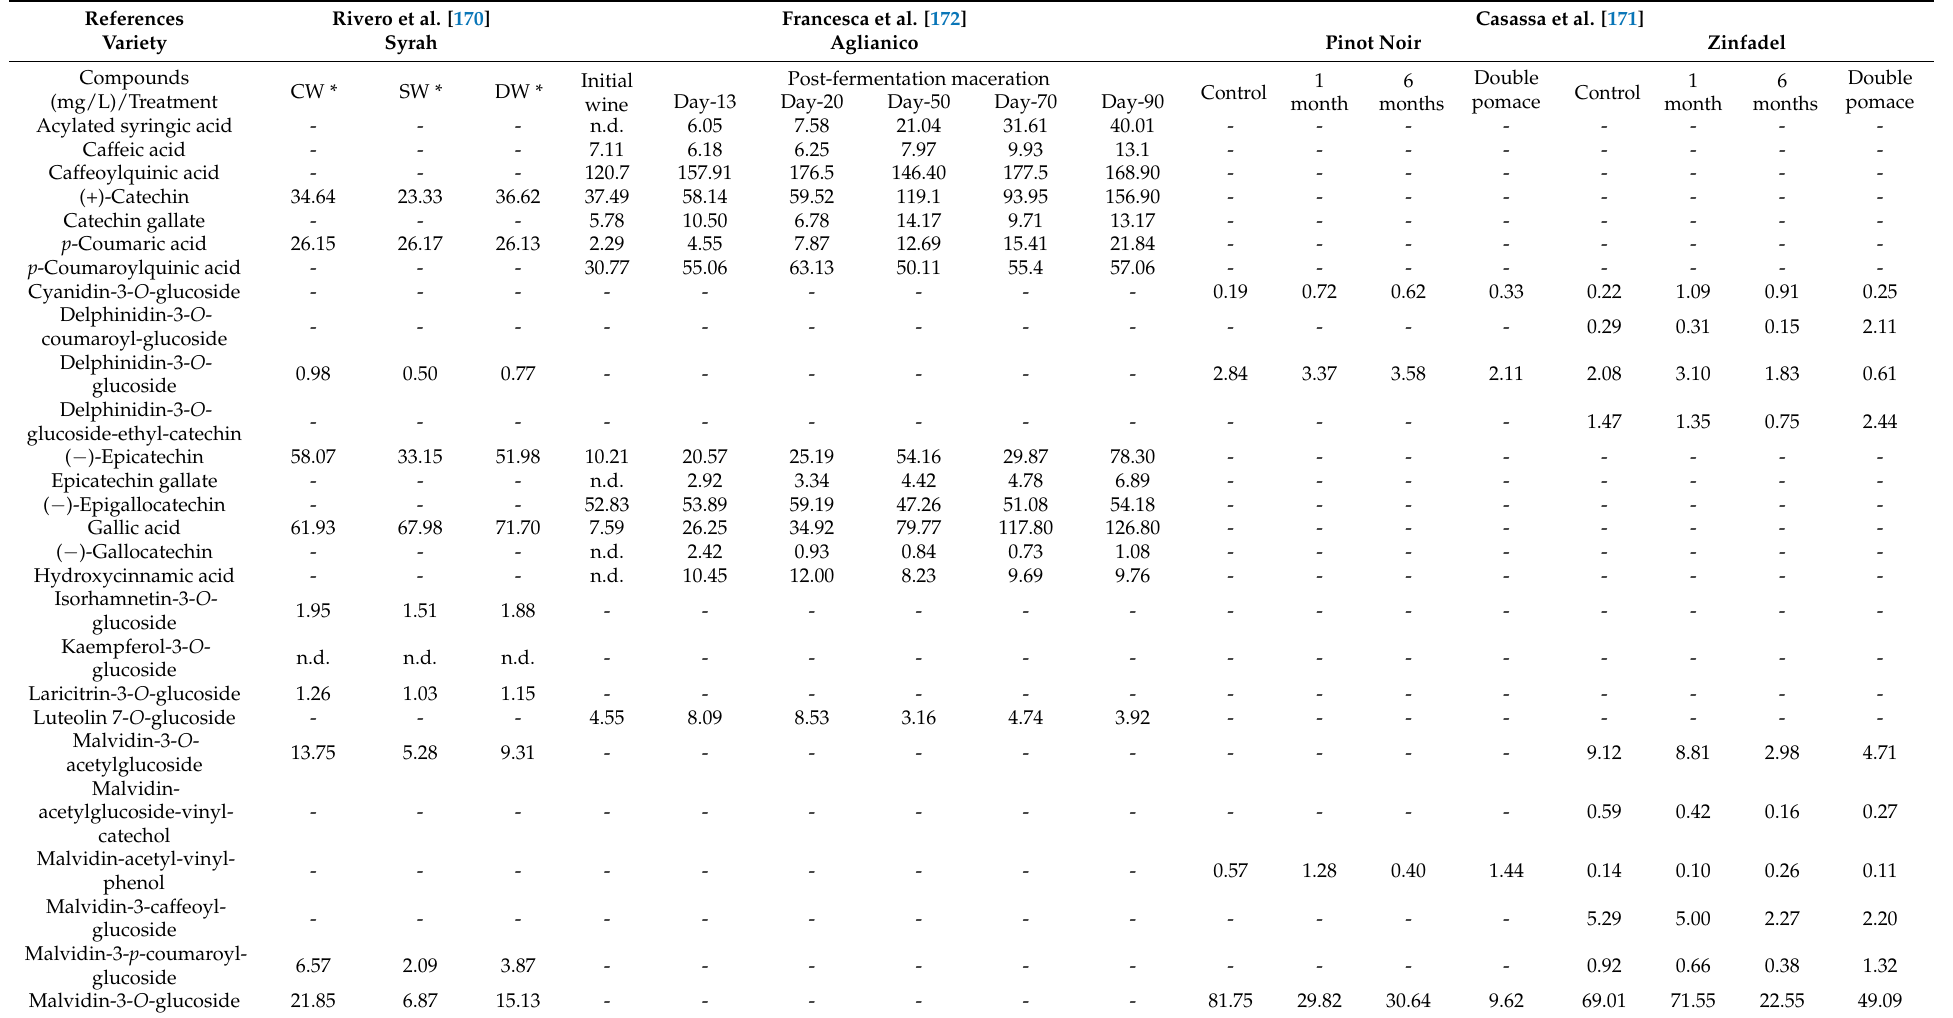
Table 4. Total phenolic concentration (mg/L) of wines that have undergone a post-fermentative maceration process. * CW: control wine (without post-fermentative maceration); SW: single post-fermentative maceration; DW: double post-fermentative maceration; n.d.: not detected; -: this compound has not been analyzed during this